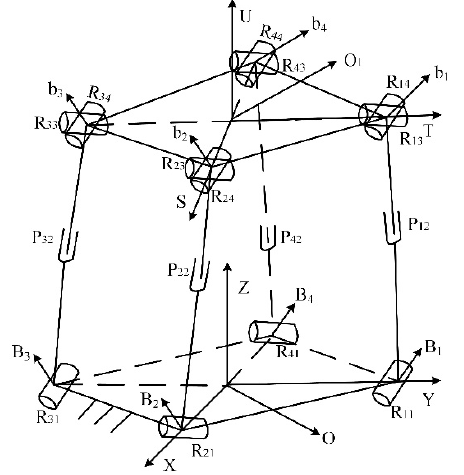
Figure 3. 4-RPU parallel topology schematic diagram.